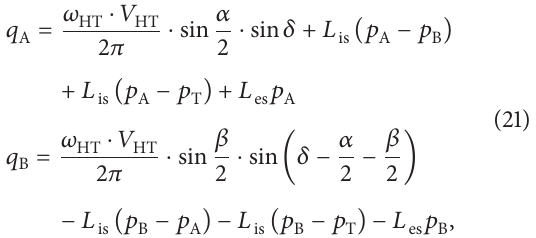
Figure 7: Torque loss and volumetric loss under different condi- tions. 𝑄 𝑟 = 𝑓 𝑄 (𝑛 𝑝 ,Δ𝑝,𝑉 𝑖 ) , and 𝑇 𝑟 = 𝑓 26 Mpa.